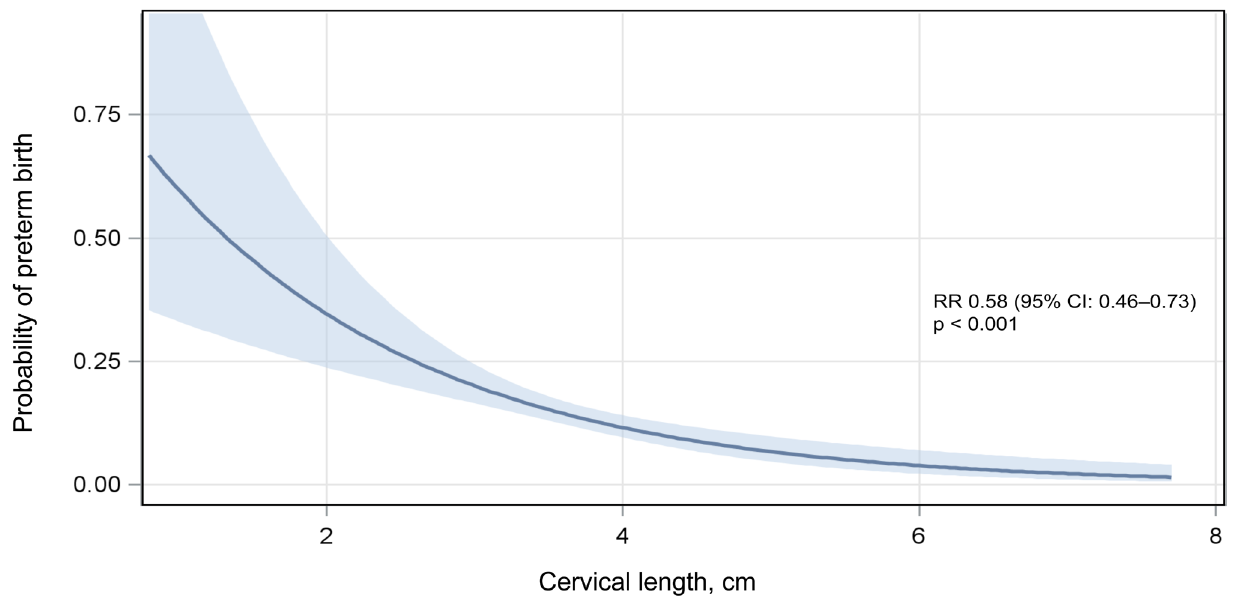
Figure 4. Predicted probability of preterm birth <37 weeks by mid-trimester cervical length. Among ZAPPS cohort participants with a cervical length measured by ultrasound in the second trimester (n=1081), the probability of preterm birth <37 weeks decreased with increasing cervical length. PTB, preterm birth; RR, relative risk; CI, confidence